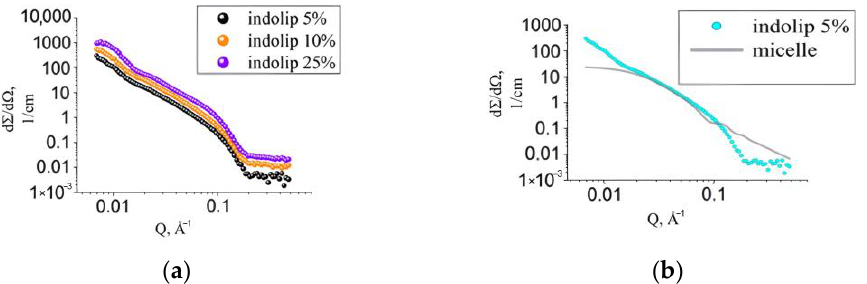
Figure 3. Experimental curves of small-angle neutron scattering of the Indolip preparation at various concentrations in heavy water ( a ), a sample with a concentration of 5% and the approximation function describing the micelle ( b ).